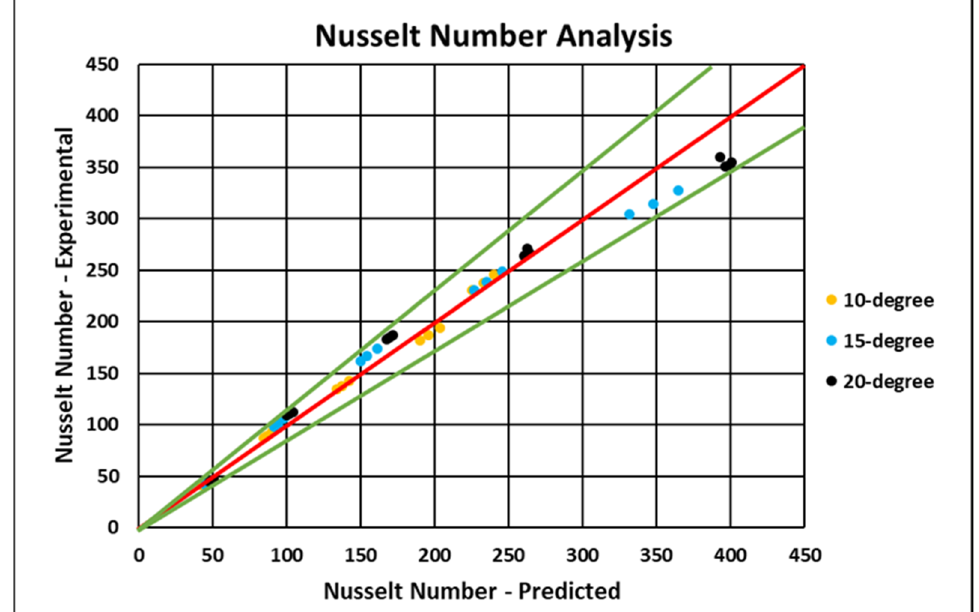
Figure 19. Observed data vs. anticipated data of Nu. Table 7. Correlation constants of Nu and f.